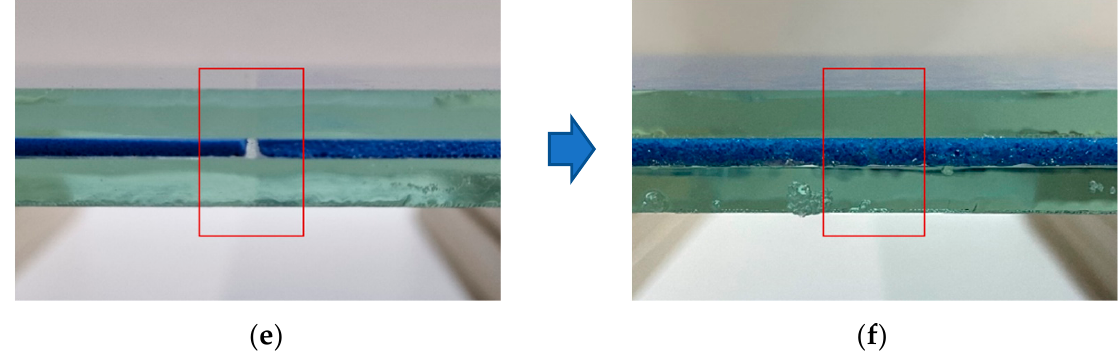
Figure 5. The schematic diagram of the waterproofing principle and the sealing status of the damaged area due to water expansion in the event of actual damage: ( a ) Water ingress through damaged areas; ( b ) Reaction with water and waterproofing due to expansion; ( c ) Damaged area (width 1mm)—plane; ( d ) After reaction with water and expansion—plane; ( e ) Damaged area (width 1mm)—section; ( f ) After reaction with water and expansion—section.